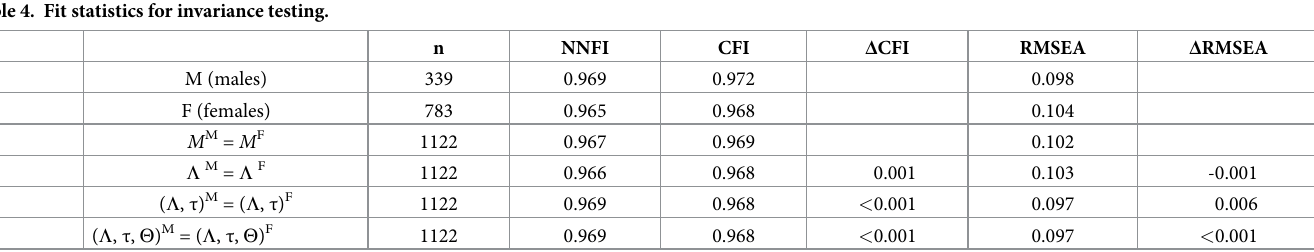
Table 4. Fit statistics for invariance